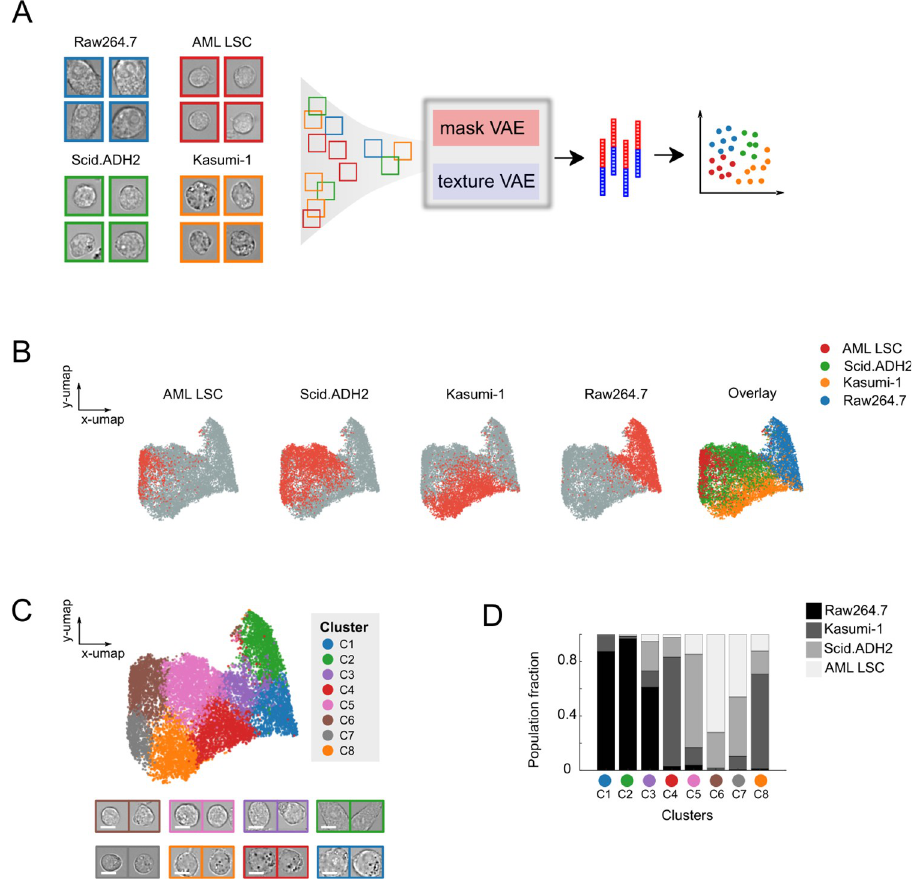
Fig 2. UPSIDE distinguishes morphologically-distinct blood cell types in a heterogeneous population. (A) Images of four different blood cell types were mixed together and passed through the UPSIDE workflow. Resultant shape and texture images were used to train concurrent VAEs. Output latent encodings were weighted relative to each other, concatenated, then projected onto a 2D plane using UMAP. (B) Dot plots show distribution of each cell type projected on 2D UMAP space made by UPSIDE. (C) 2D UMAP projection of the VAE-generated encodings that have been grouped into different morphological clusters using Louvain clustering algorithm. Representative brightfield cell crop images from the different clusters were listed. Scale bar represents 5 μ m. (D) Cell type fractional composition within each cluster. A fixed number of cells from each cell type were sampled, and the cluster-wised cell type composition was calculated from this pooled